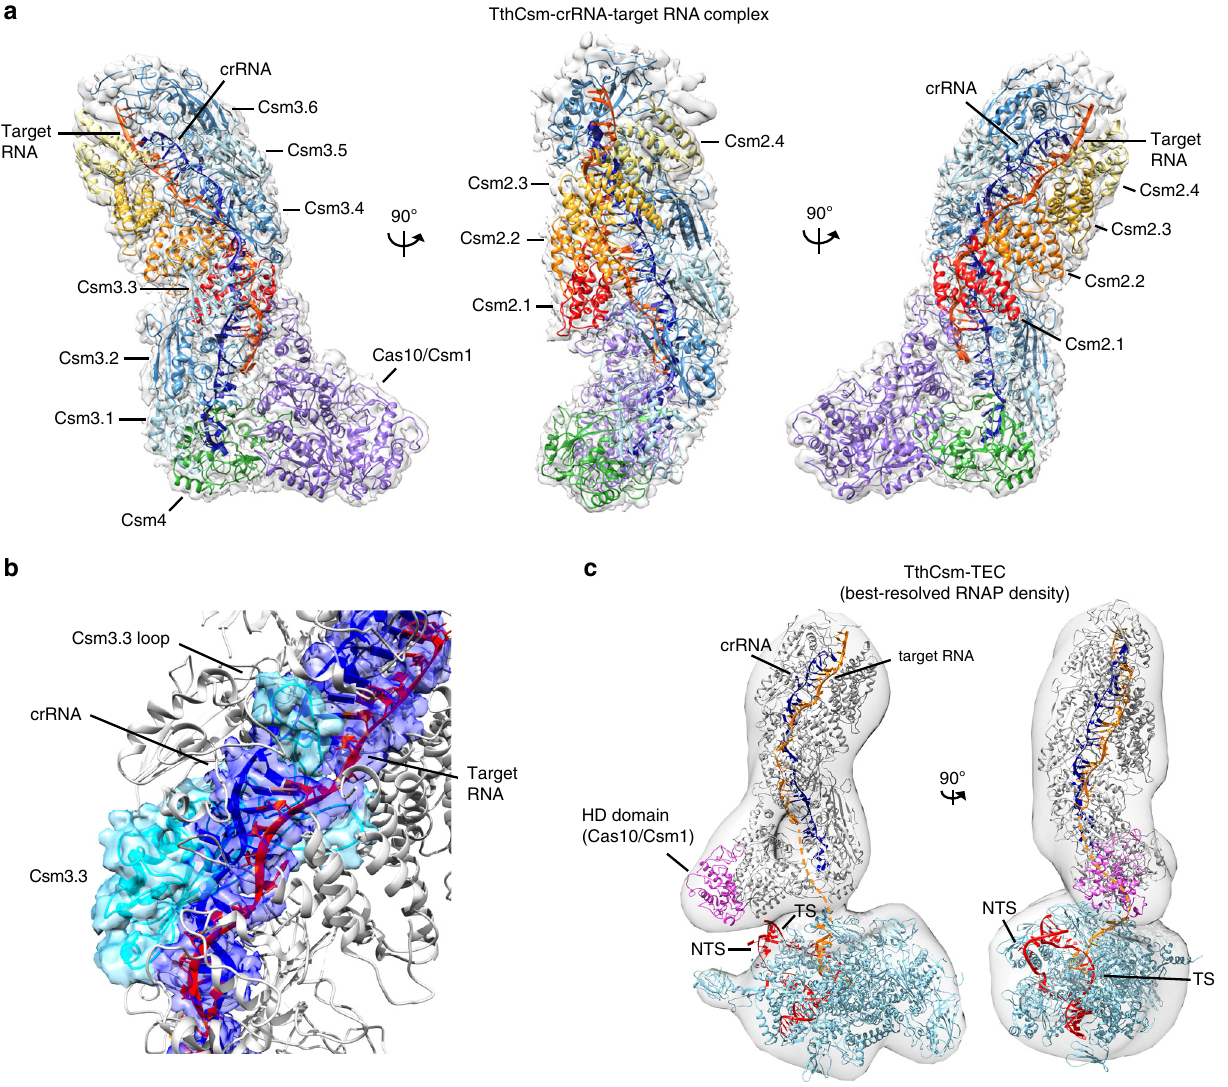
Fig. 3 Cryo-EM structures of target RNA-bound TthCsm and modeling of the TthCsm-TEC complex. a Cryo-EM structure and model of target RNA-bound TthCsm. TthCsm subunits, crRNA, and target RNA are labeled in the different views. Each view is rotated by 90 ˚ , as indicated by arrows. b Detailed view of the discontinuous crRNA and target RNA hybrid, showing the base pairs fi t into the EM density of the RNA hybrid. A loop in each Csm3 subunit inserts after every 5-nt segment and fl ips out the 6th base. The EM density of the crRNA:target RNA hybrid and the modeled crRNA strand are colored dark blue, and the modeled target RNA strand is colored red-orange. The EM density and model corresponding to the third Csm3 subunit (Csm3.3) is colored light blue. c Models of RNA-bound TthCsm and the TEC complex fi t into the negative stain EM map. The HD domain of Cas10/Csm1 is colored pink, the nontemplate strand (NTS) and template strand (TS) are colored red, the RNA transcript is colored orange, and the crRNA is colored dark blue. A dotted orange line is used to represent the segment of RNA between the RNA exit channel and the TthCsm bound target sequence. TthCsm is colored gray and the protein subunits of the RNAP are colored light blue. The orientation of the RNAP was determined using the features of the EM density map (3D model 8 in Fig.